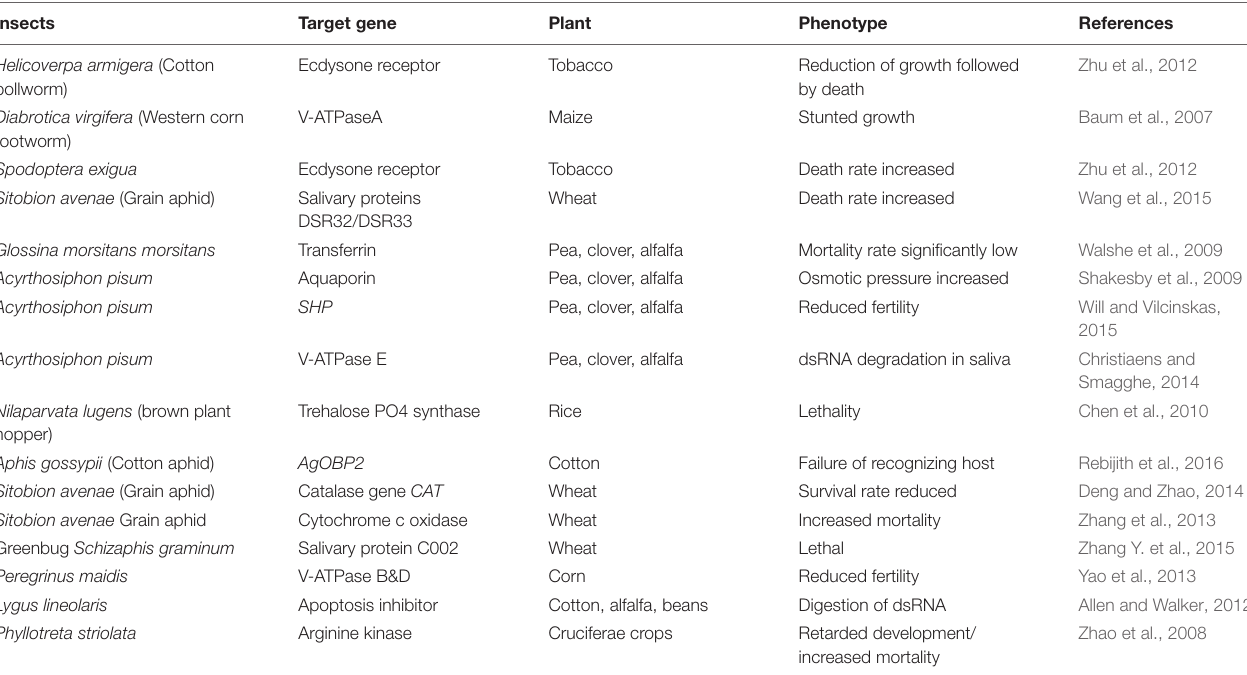
FIGURE 1 | (A) In RNAi-mediated gene silencing, long dsRNA/hpRNA gets chopped off into short (21–23 nucleotides) interfering RNA duplexes (siRNAs). siRNA duplexes unwind and one of the strands (Guide strand) gets incorporated into the RISC complex, which finally degrades the targeted complementary mRNA. RISC complex gets recycled again; (B) Dicer-mediated processing of long dsRNA in Arabidopsis thaliana . DCL2 generates 22 nucleotide-long siRNAs, which interacts with AGO1 and recruits RDR6 to induce transitive silencing. DCL3 generates 24 nucleotide-long siRNAs, which interacts with AGO4 and induces DNA methylation by recruiting DNA PolV, whereas DCL4 generates 21 nucleotide-long siRNAs, which interacts with AGO1 and directs the cleavage of complementary mRNA. TABLE 1 | RNAi-targeted editing in plants against